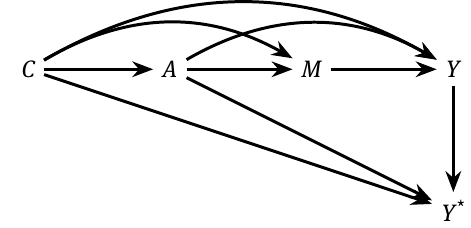
Figure 4: Differential misclassification in the measurement of outcome Y * , no direct path from M to Y